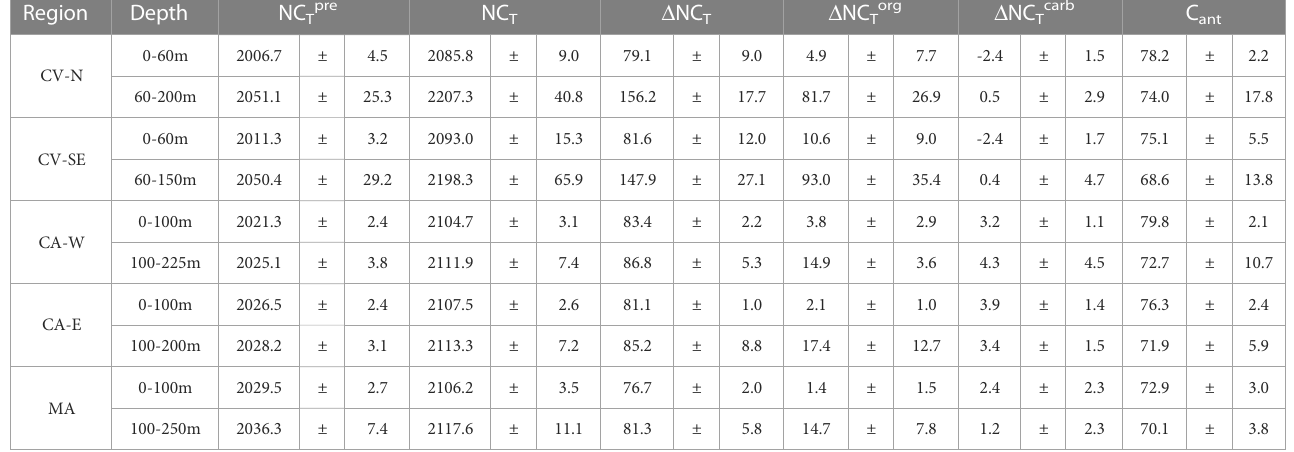
TABLE 3 Average content of calculated NC Tpre and determined NC T above and below the MLD in CV-N, CV-SE, CA-W, CA-E and MA and relative contribution of the organic carbon pump ( D NC Torg ), carbonate pump ( D NC Tcarb ) and C ant in the observed increase of NC T from NC Tpre . Region